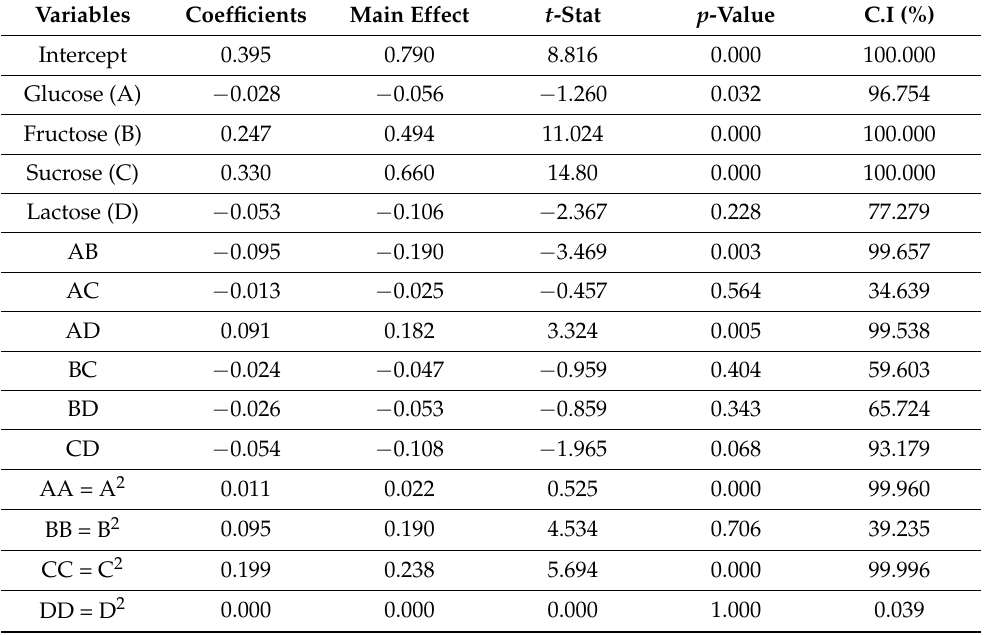
Table 2. Fit Statistics of sugar-stabilized AgNPs using SCD design.